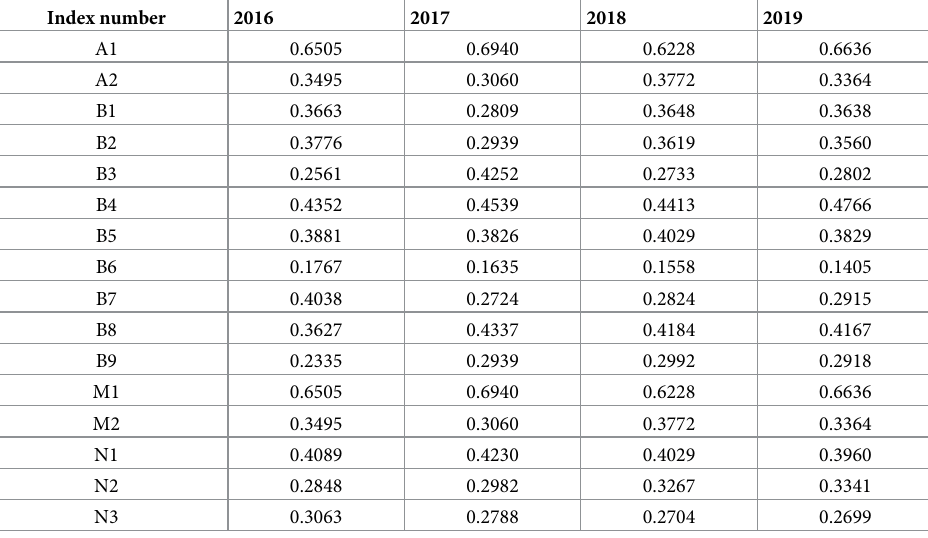
Table 5. Indicator weights for the rural logistics